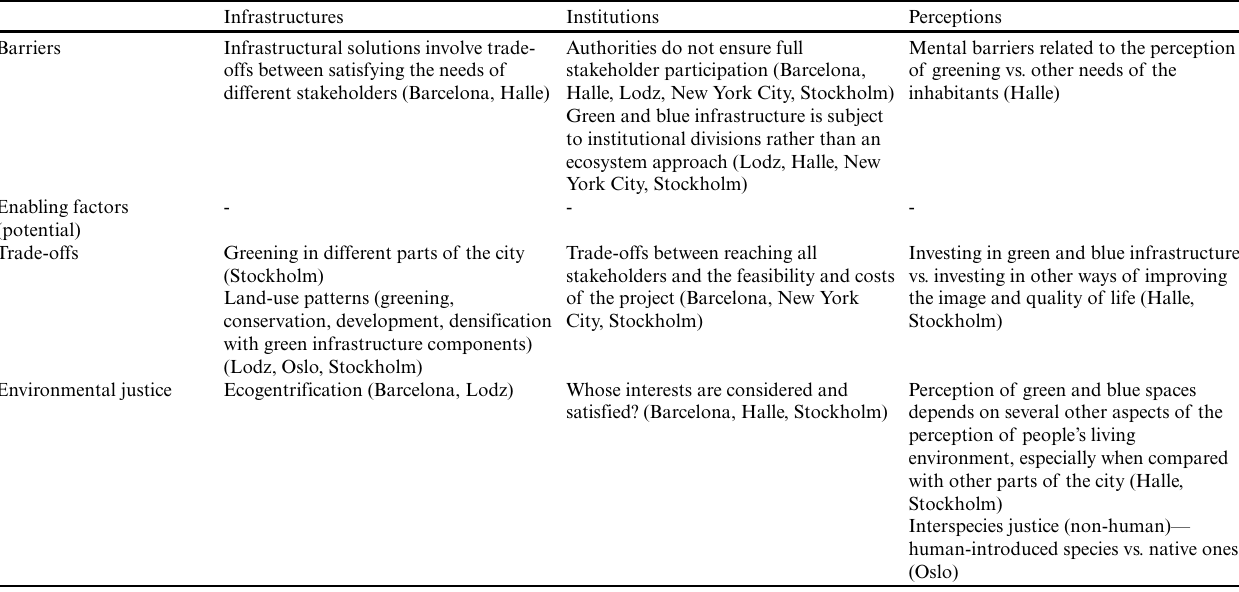
Table 10. ENABLE filters mediating the flow of benefits from GBI to potential beneficiaries translated into an analytical framework for the assessment of GBI-related initiatives—synthesis of key issues observed in our case